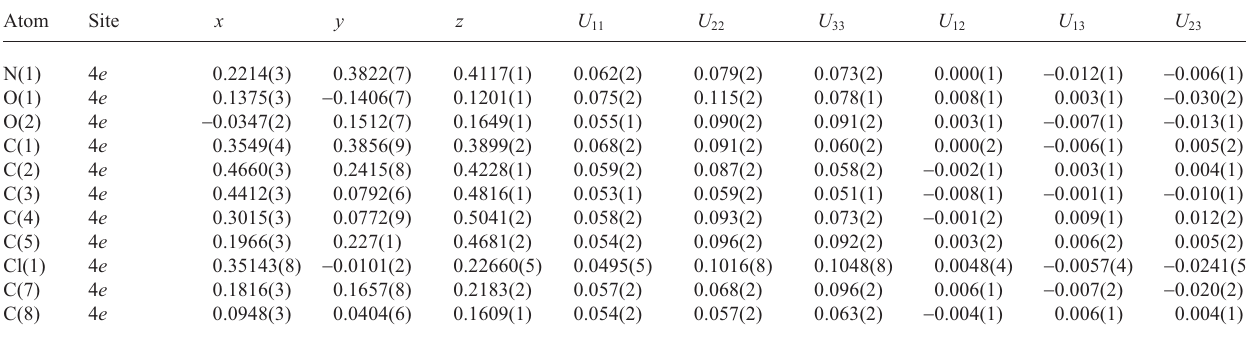
Table 3. Atomic coordinates and displacement parameters (in Å 2 )